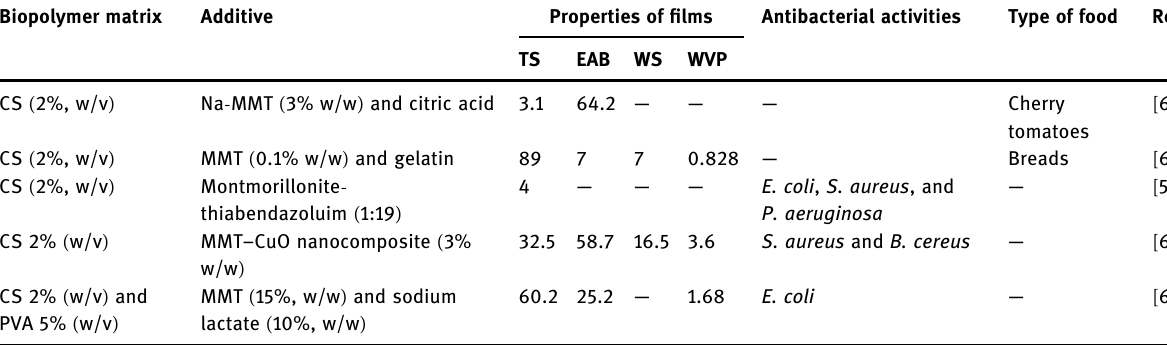
Table 2: Example of CS - based fi lms with montmorillonite as fi ller for antibacterial food packaging applications Biopolymer